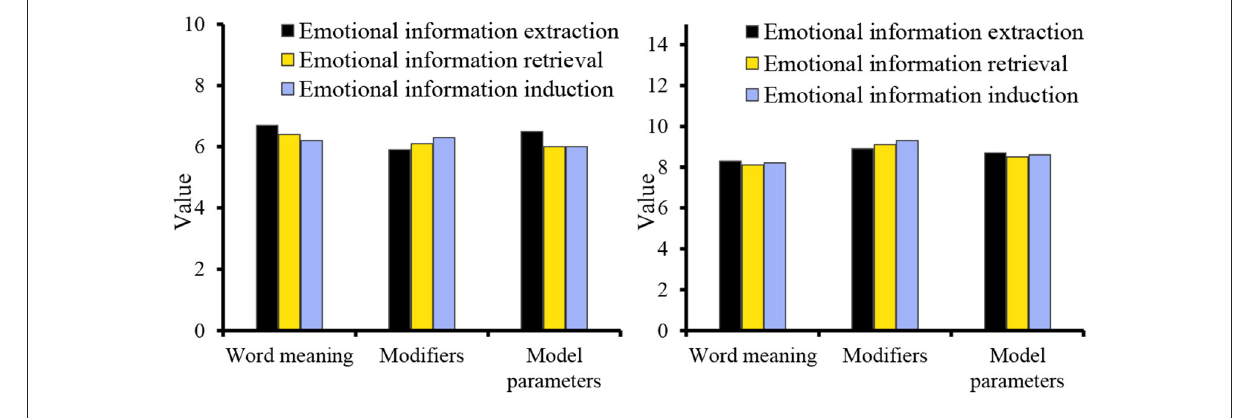
FIGURE10 Sentiment analysis of the